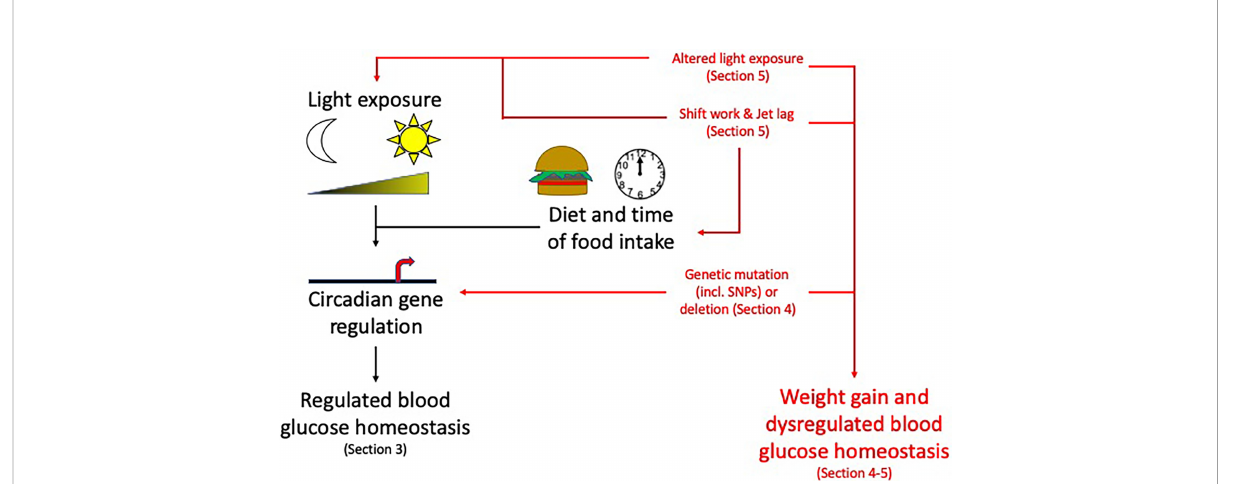
FIGURE 3 Circadian rhythms and their disruption: Topics to be discussed in this review. Circadian rhythms, in fl uenced by light/dark cycles and diet and time of food intake, control many pancreas functions. Disruption to these circadian in fl uences (altered light exposure, shift work/jet lag, genetic mutations) can lead to weight gain and dysregulated blood glucose homeostasis increasing the risk of developing obesity and T2DM. For information related to these factors altering the circadian rhythms please see the speci fi c sections mentioned above within the review. Section 3: Circadian rhythms in the pancreas, Section 4: Molecular circadian rhythms in the pancreas and Section 5: Modulation of circadian rhythm.